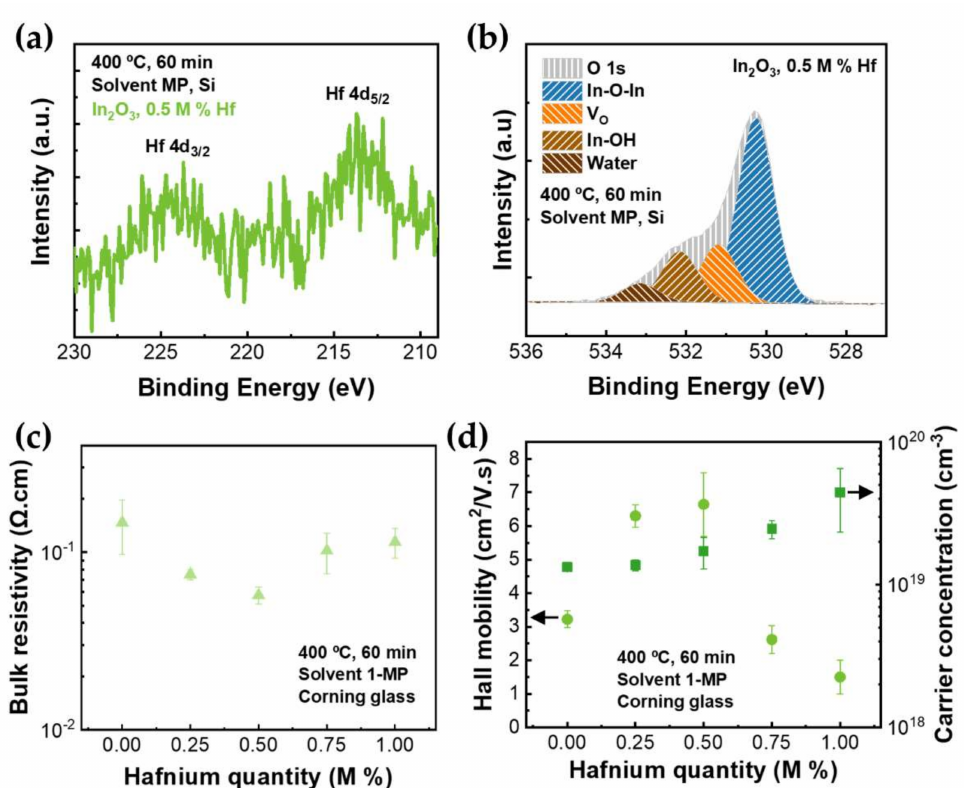
Figure 4. ( a ) XPS spectra of the Hf4 d and ( b ) the deconvolution of O1s peak of films formed at 0.5 M% of Hf-doping levels; ( c ) bulk resistivity and ( d ) Hall mobility and carrier concentration obtained by Hall effect measurements for the undoped and Hf-doped In 2 O 3